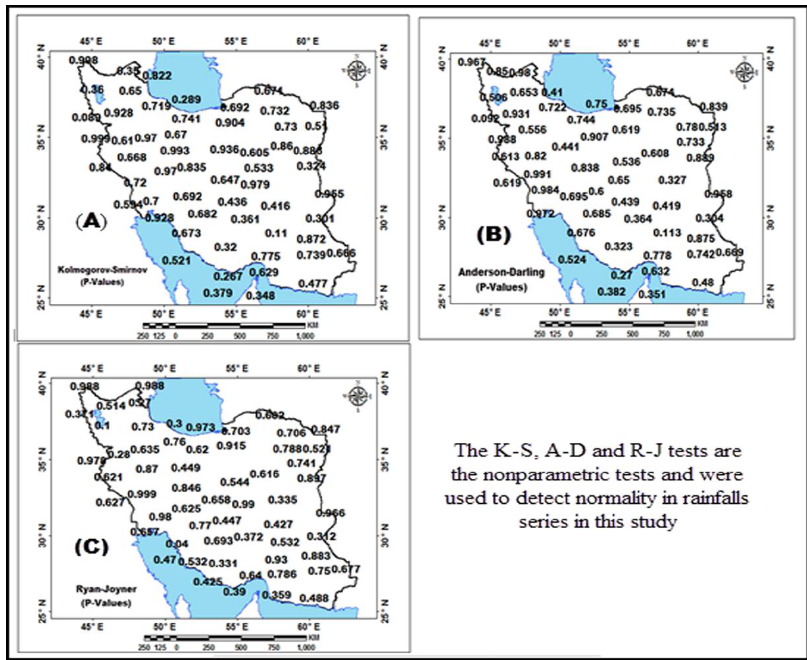
Figure 4. Results of K-S ( A ); A-D ( B ) and R-J ( C ) tests for rainfall in Iran.